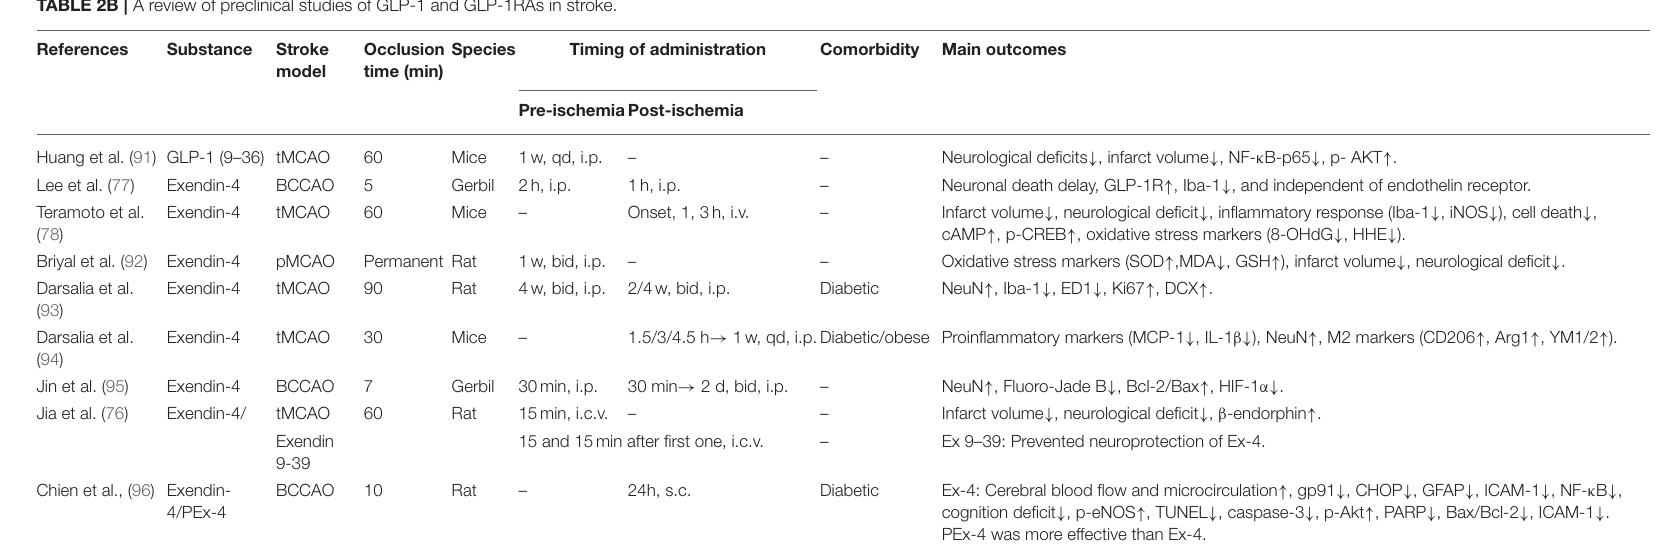
TABLE 2B | A review of preclinical studies of GLP-1 and GLP-1RAs in